Question: Which kind of chart has been used to present this data?
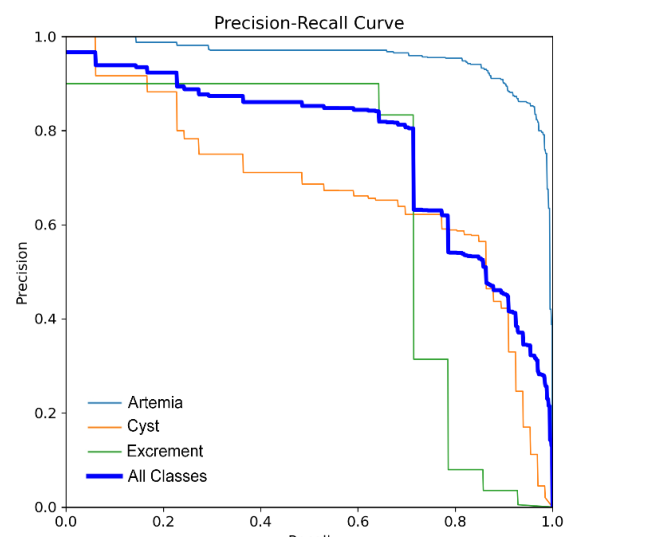
Answer: line